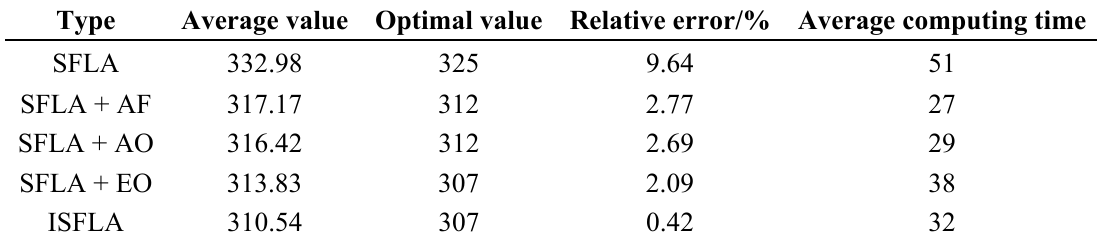
Table 2. Computational results of the MK09 problem of several methods. AF, adjustment factor; AO, adjustment order; EO, extremal